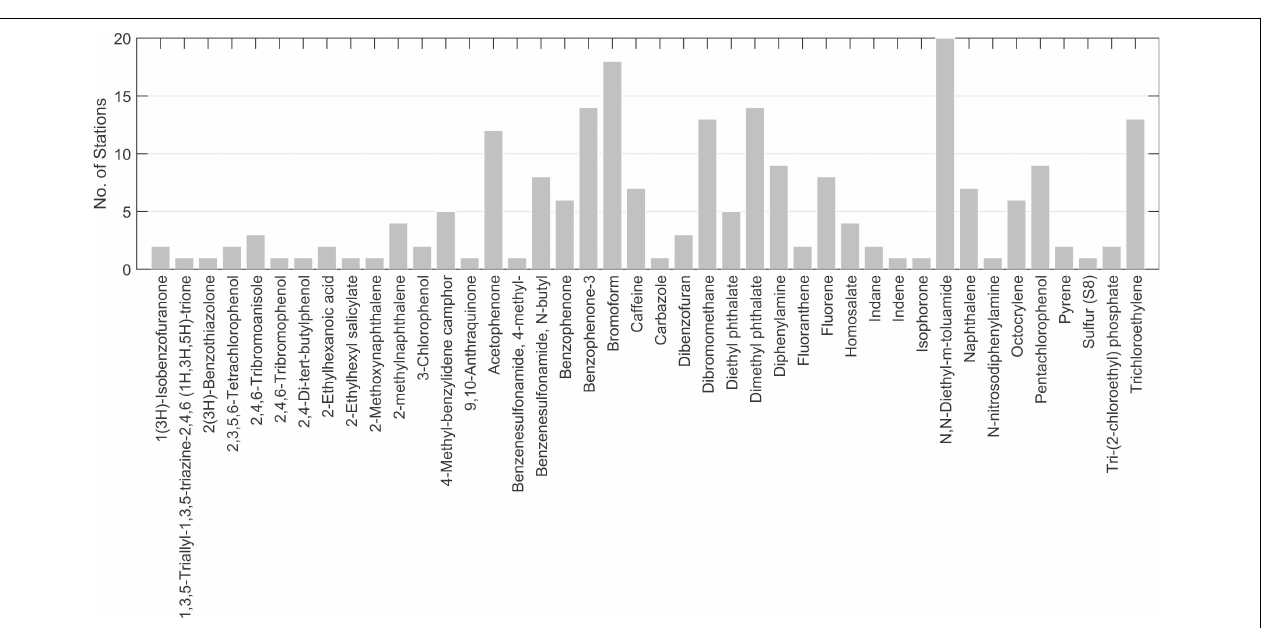
FIGURE 7 | Contaminants detected and the total number of stations where they were